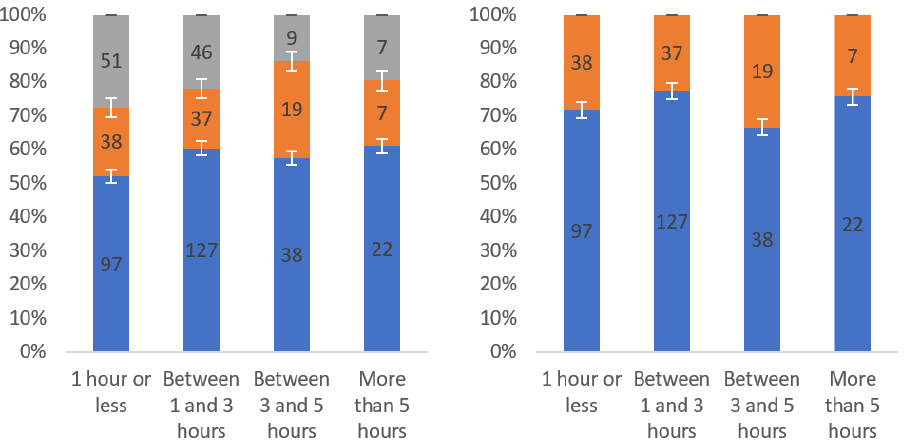
Figure 18. Responses regarding others’ willingness to review by internet usage level including ( left ) and excluding ( right ) unsure and excluding ( right ) unsure responses.